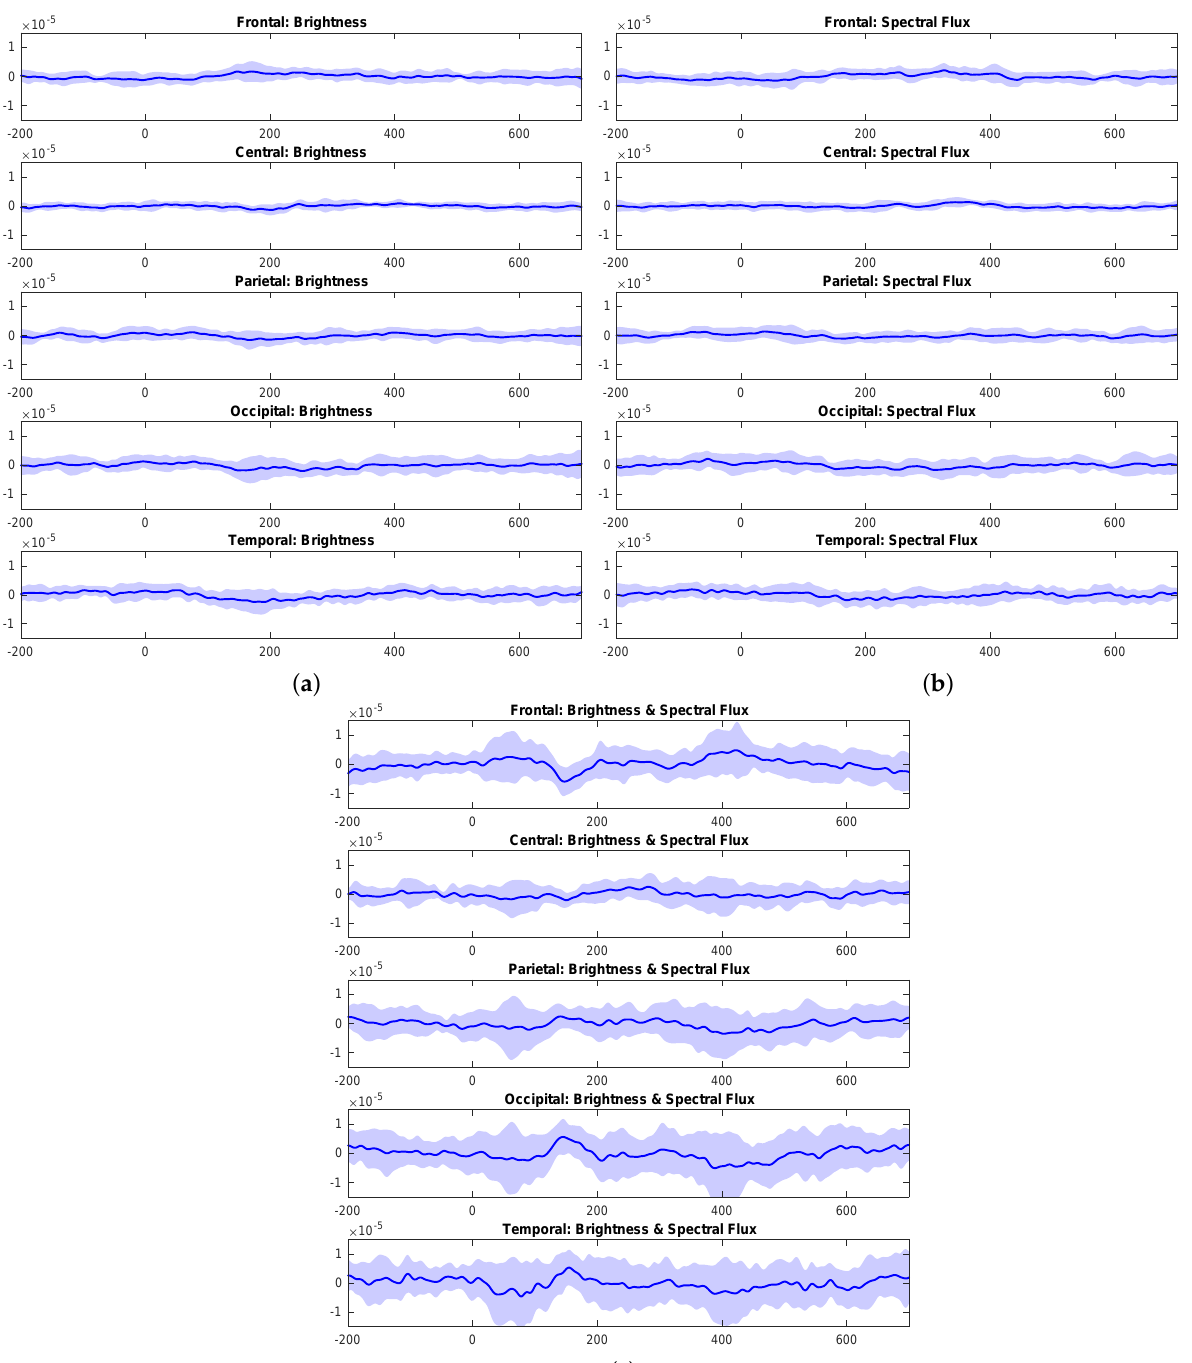
Figure 1. ( a ) EEG data related to changes in brightness. ( b ) EEG data related to changes in spectral flux. ( c ) EEG data related to changes in both brightness and spectral